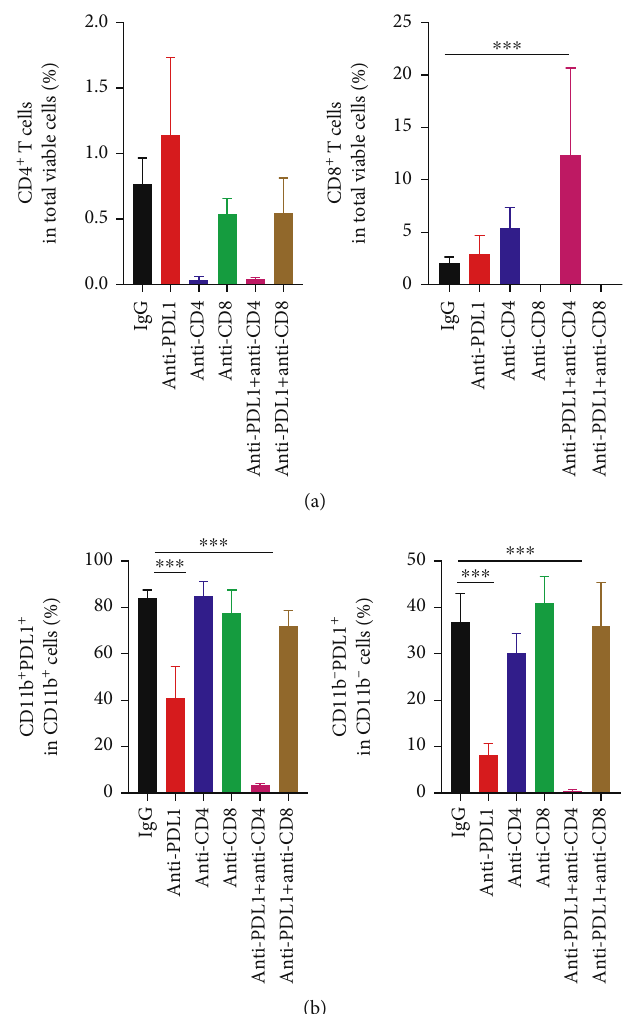
Figure 2: Anti-PD-L1 therapy decreased the proportions of intratumoral PD-L1 + immune cells in a CD8 + T cell dependent manner, while CD4 + T cells antagonized those e ff ects. CT26 tumor-bearing mice were prepared and treated as described in Figure 1. On day 12 post anti-PD-L1 treatments, tumor tissues were harvested and analyzed by fl ow cytometry. (a) The proportions of intratumoral CD4 + and CD8 + T cells were analyzed by fl ow cytometry. (b) The percentages of intratumoral PD-L1 + CD11b - cells in lymphoid cells and PD-L1 + CD11b + cells in myeloid cells were assessed by fl ow cytometry. Signi fi cant di ff erences were determined by one-way ANOVA. Data were from one experiment representative of two independent experiments with similar results ( n = 7 − 8 mice per group). Data were shown as means ± SD . ∗ P < 0 : 05 , ∗∗∗ P < 0 : 001